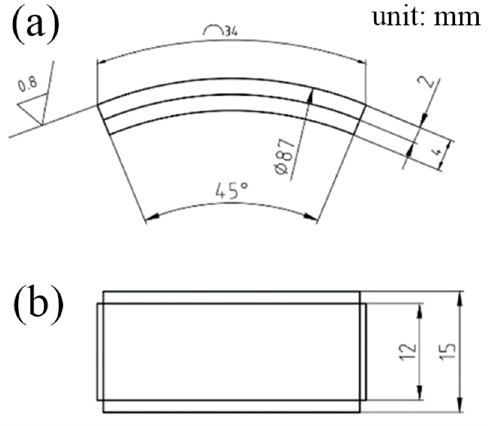
Figure 1. Dimensions of the arc-shaped sample: ( a ) side view, and ( b ) vertical view. Table 2. Composition of the experiment solution. The sample surface of the arc-shaped specimen was grinded step by step with 360, 600, 800, 1000, 1500, and 2000 # abrasive papers and polished with corundum powders of 2.5 µ m in diameter. It was then immersed into distilled water to clean and defat with ethanol and acetone, and at last weighed after cold air drying.